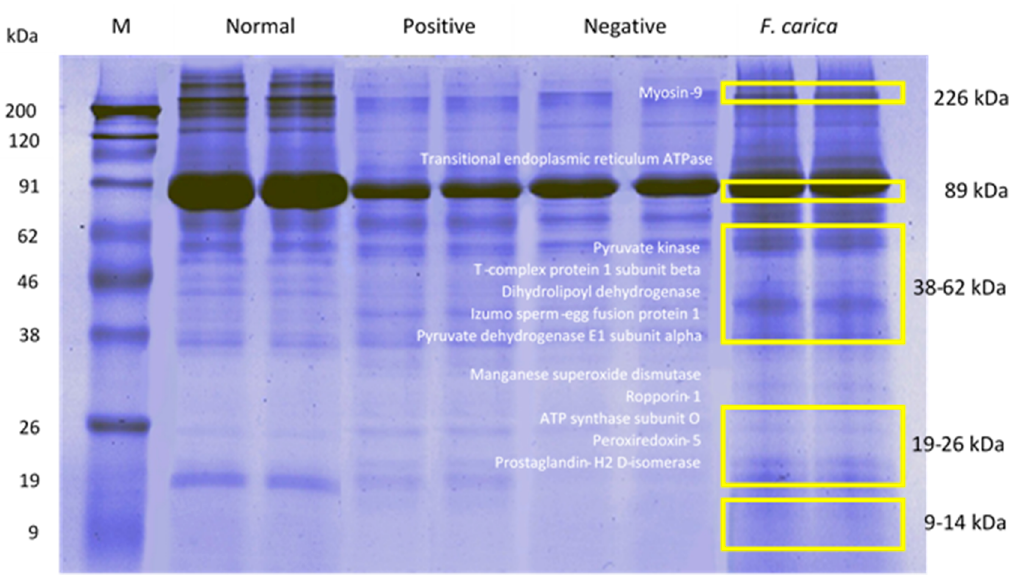
Figure 8. The distribution of unique fertility-related protein of FC treated sperm group based on molecular weight in SDS-PAGE.